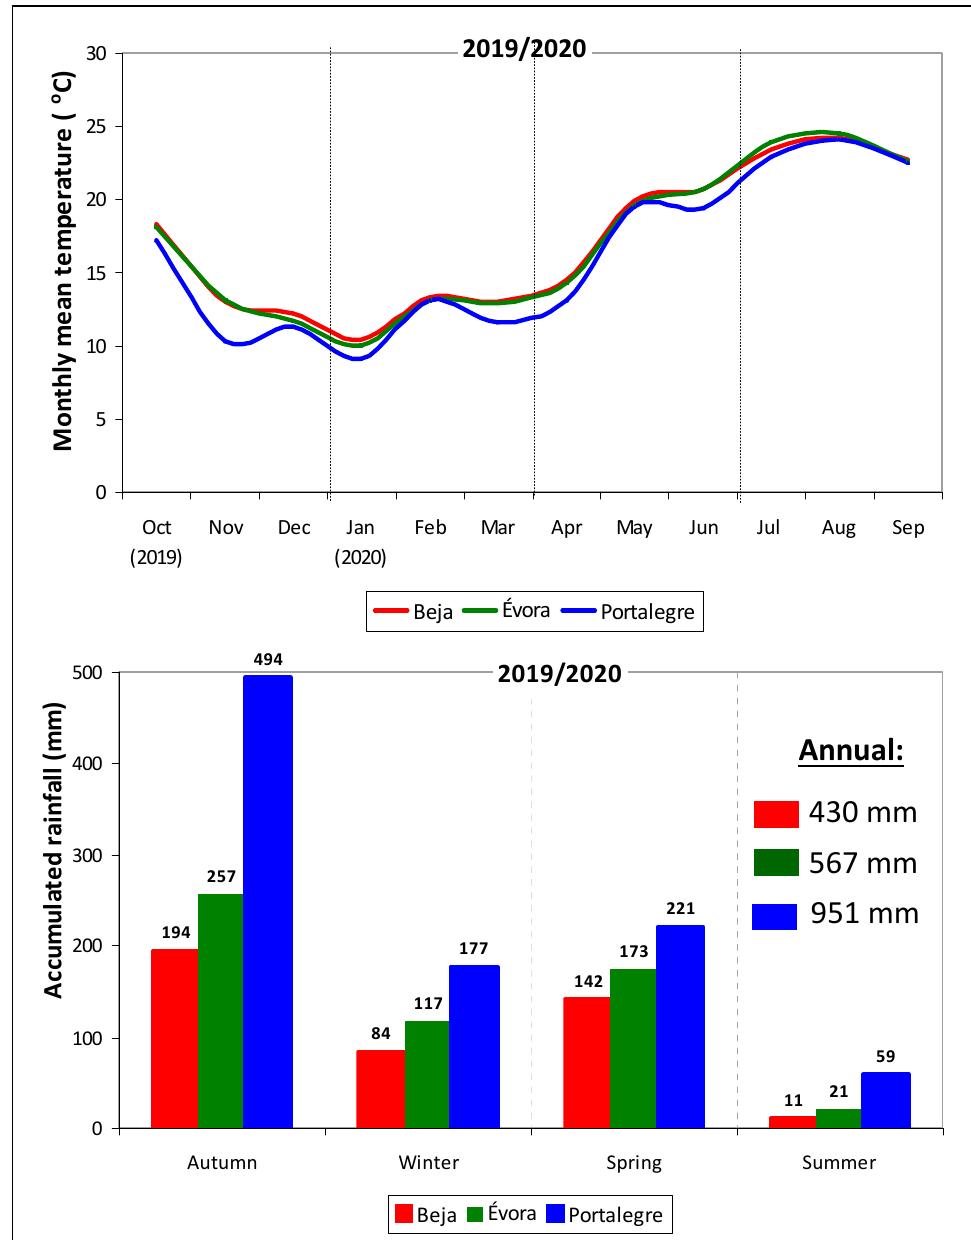
Figure 5. Thermo-pluviometric data of Beja, Évora, and Portalegre districts of the southern Alentejo region of Portugal between October 2019 and September 2020 (source: Portuguese Institute of Sea and Atmosphere).